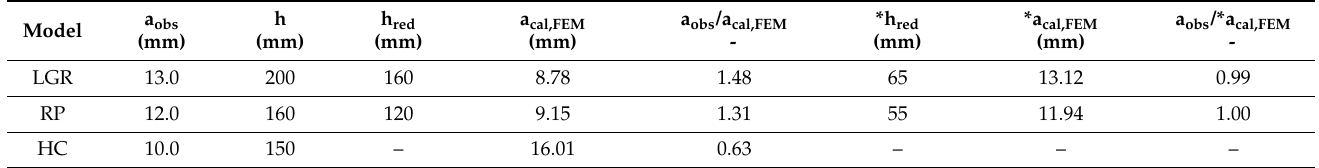
Table 9. Compared results from tests and FEM calculations for long-term